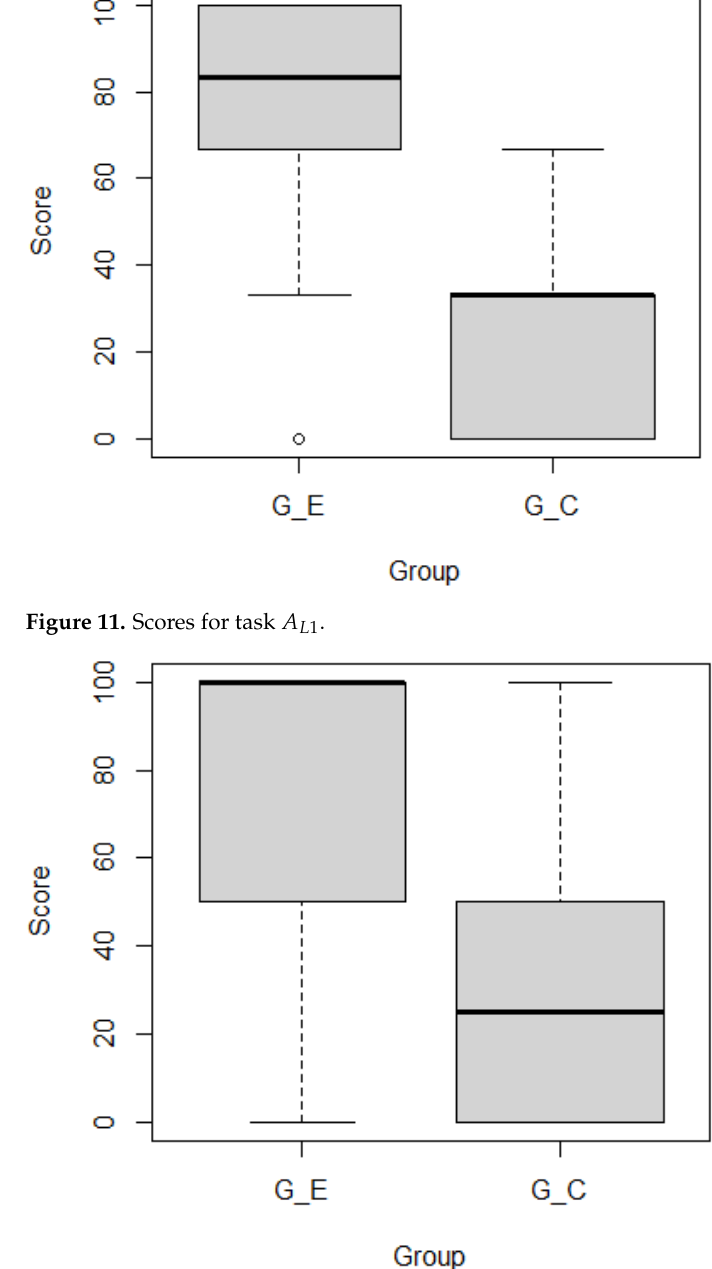
Figure 12. Scores for task A L 2